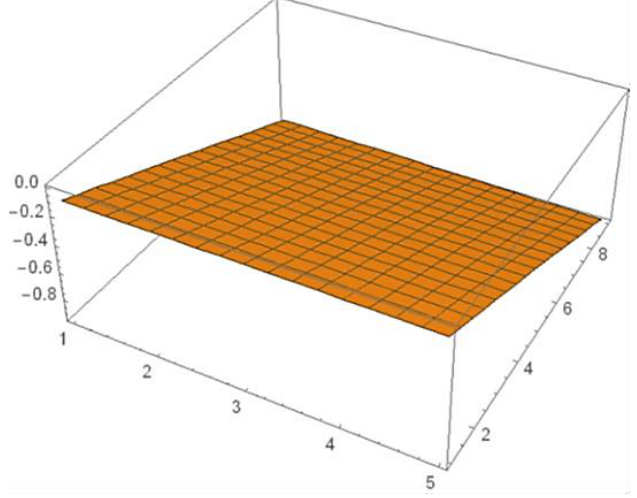
Figure 5. The exact solution (lower solution) of Equation (33) at t = 0.01, x 0.1, r = 0 and β =